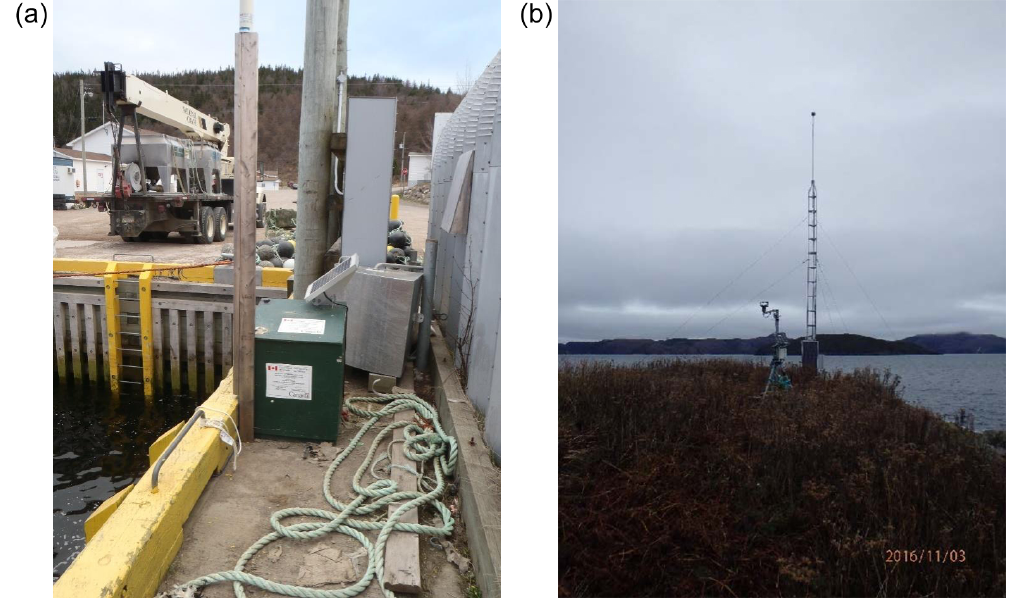
Figure A1. Pool’s Cove (POOLC) tide gauge (a) and Dog Island (DOGIS) weather stations (b)